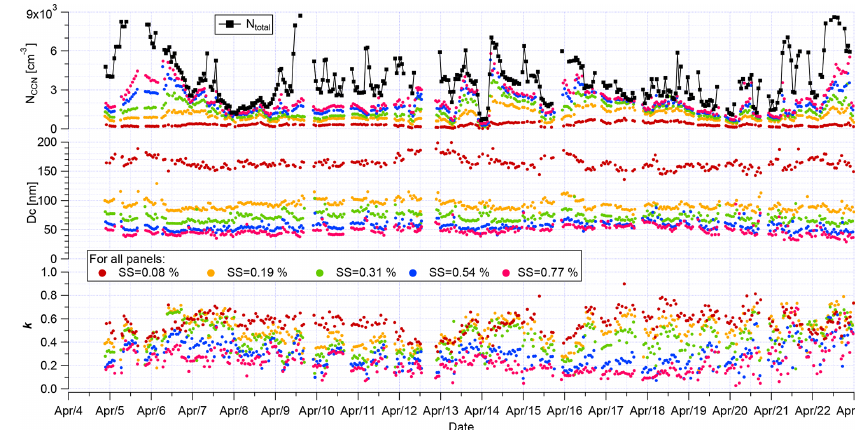
Figure 7. Time series of N total , N CCN , the inferred d crit , and κ values at different supersaturations.